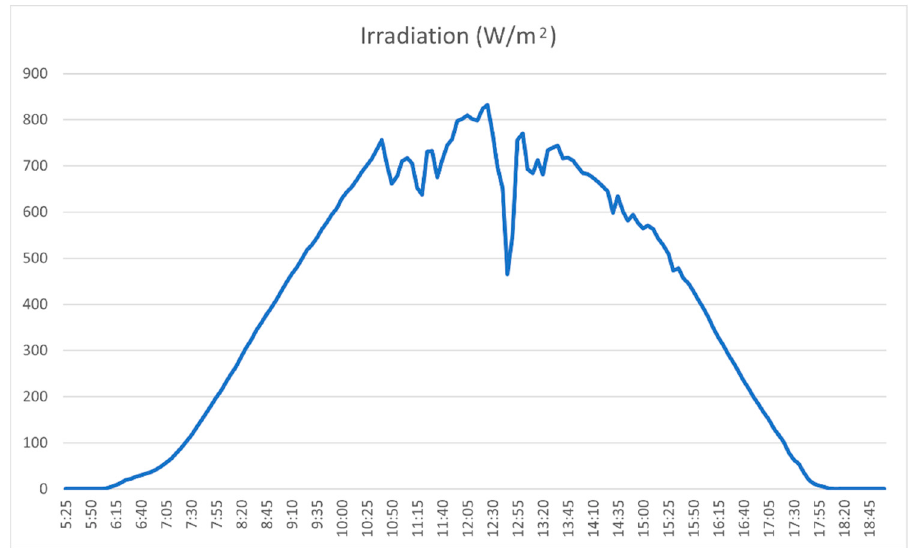
Figure 12. Irradiation in the case study for the day 27 August 2019.